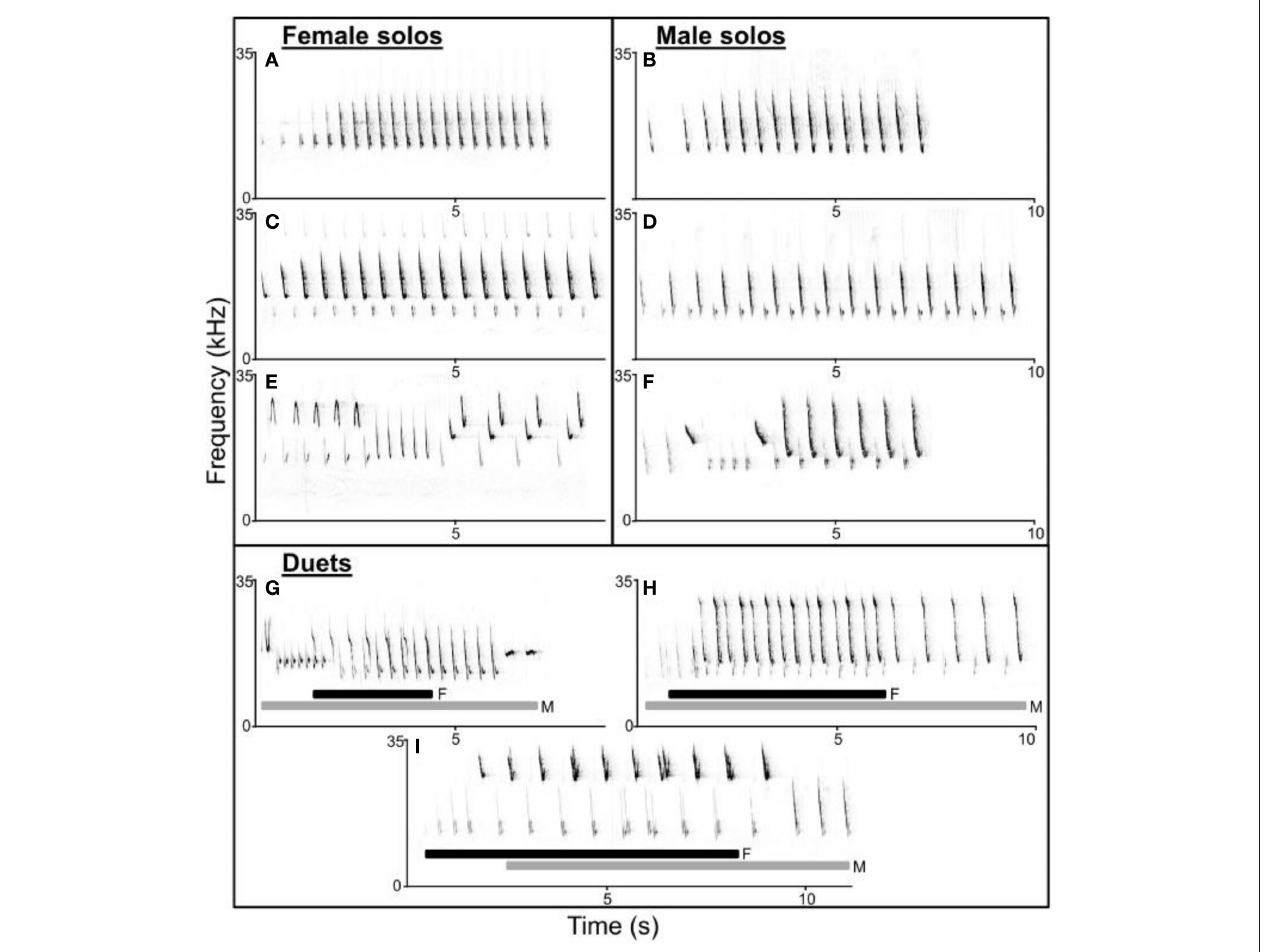
FIGURE 1 | Spectrograms of troupial ( Icterus icterus ) female (A,C,E) and male (B,D,F) solos and duets (G–I). Female and male songs have similar structure (A–D) and range from 1 to 3 alternating syllables most often used in repeating motifs. Both female and male songs can have simple (A,B) or complex (E,F) syllable diversity and order. Duets vary structurally including both male-initiated ( G,H ; female part of duet underlined by black bars) and female-initiated ( I ; male part underlined by gray bars) duets. In addition, both songs and syllables within duets may overlap to varying extents and troupials may use different (G) or similar (H,I) song types as their mate within duets.